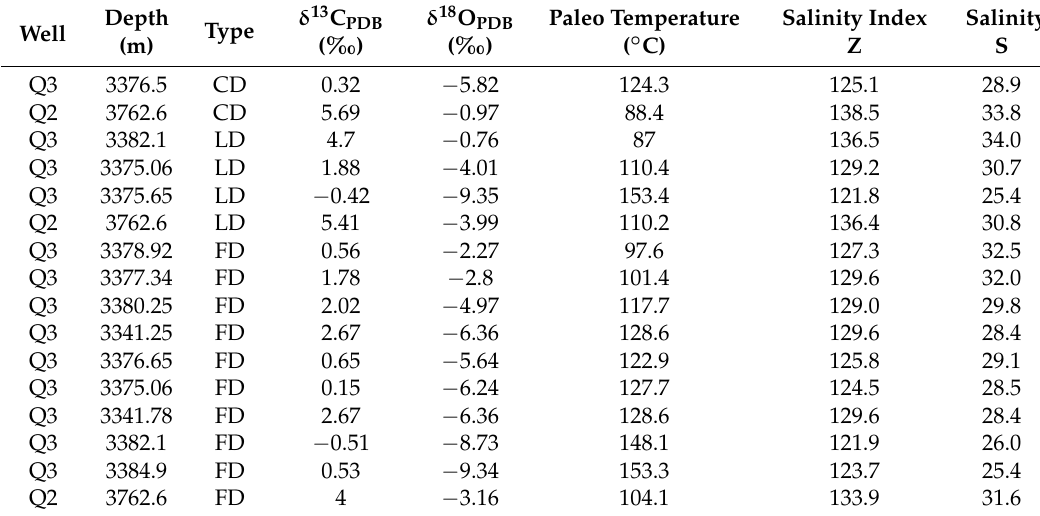
Table 1. Carbon and oxygen isotope data of different types of dolomite.